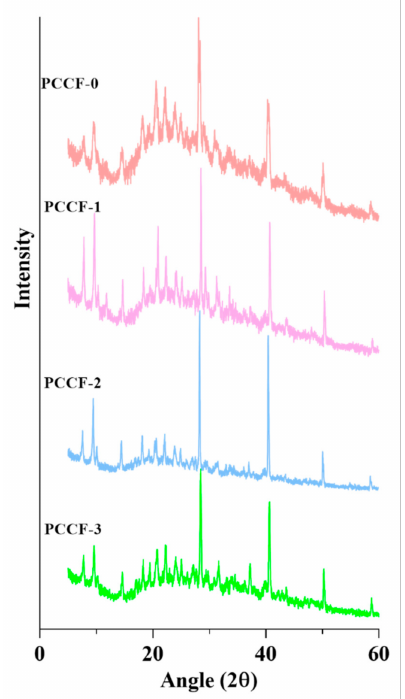
Figure 3. X-ray diffractograms of PCCF.